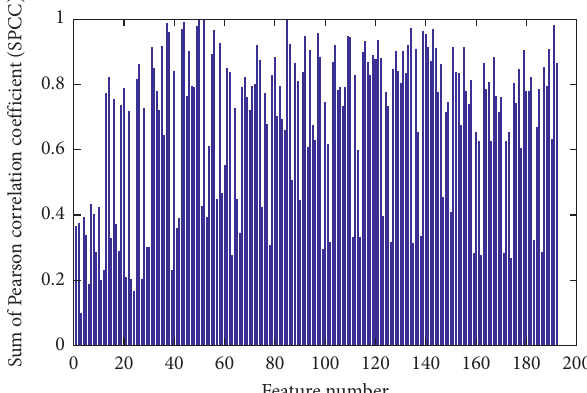
Figure 30: The sum of the Pearson correlation coefficient.